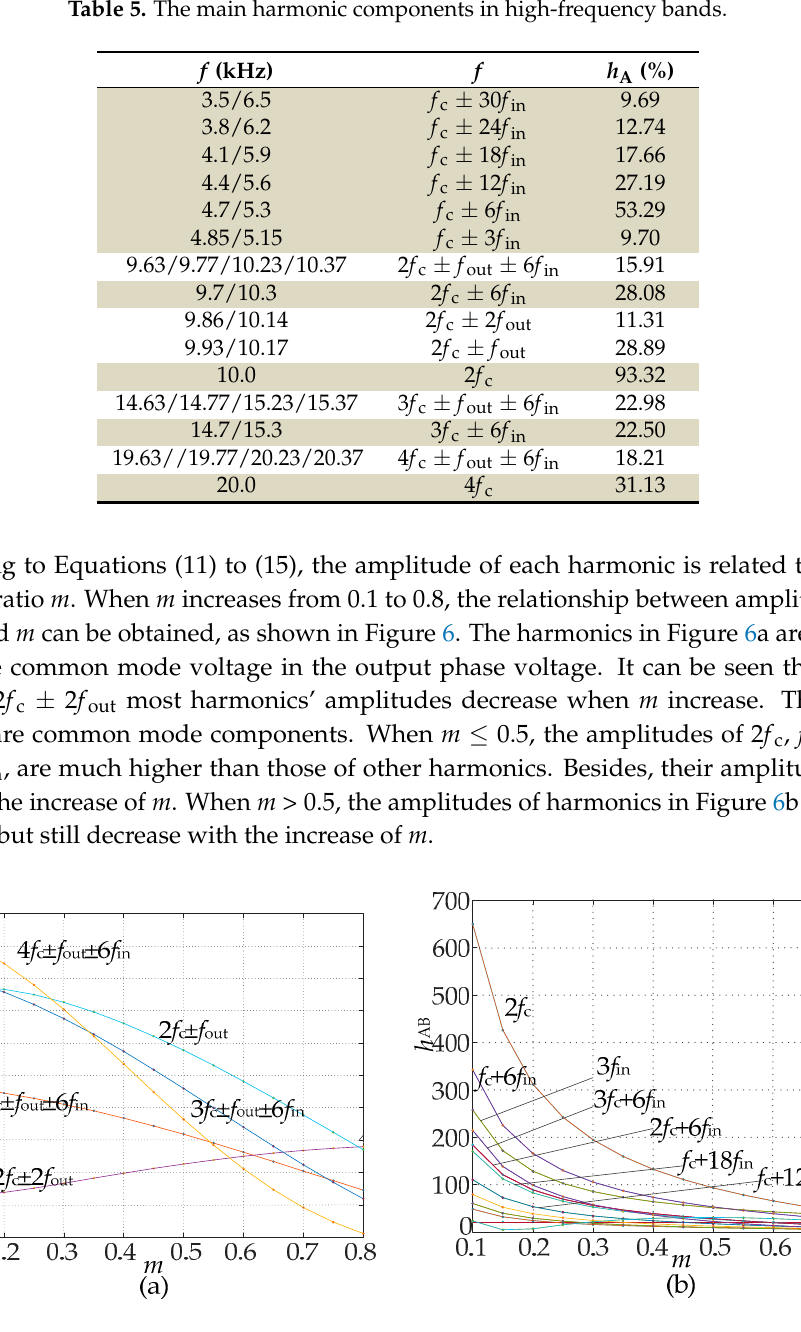
Figure 6. The relationship between main harmonic components and m in output phase voltage ( a ) components other than common mode voltage ( b ) common mode components.